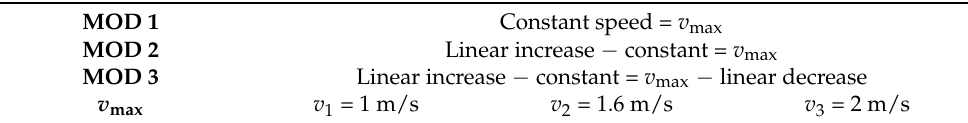
Table 2. Walking speed models and